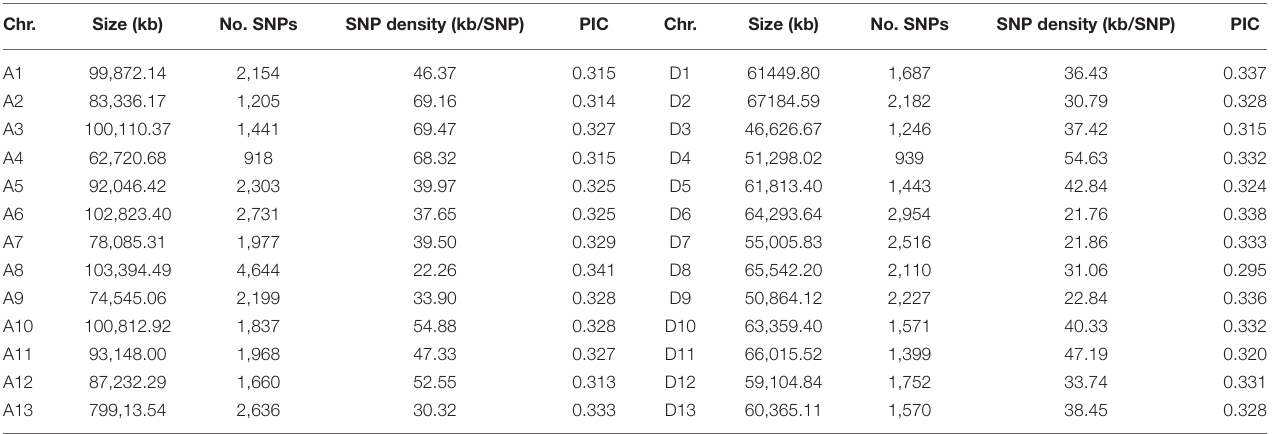
TABLE 2 | Summary of SNPs in the 26 chromosomes of G. hirsutum races.